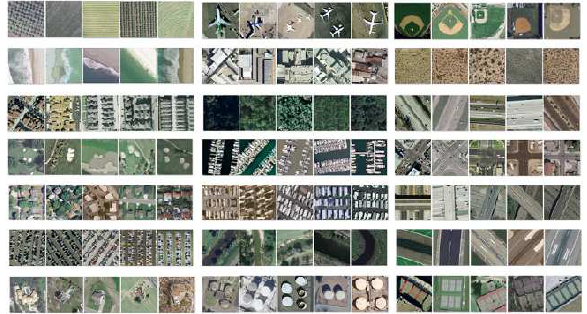
Figure 1. Image patches of the 21 land-use/land-cover classes.